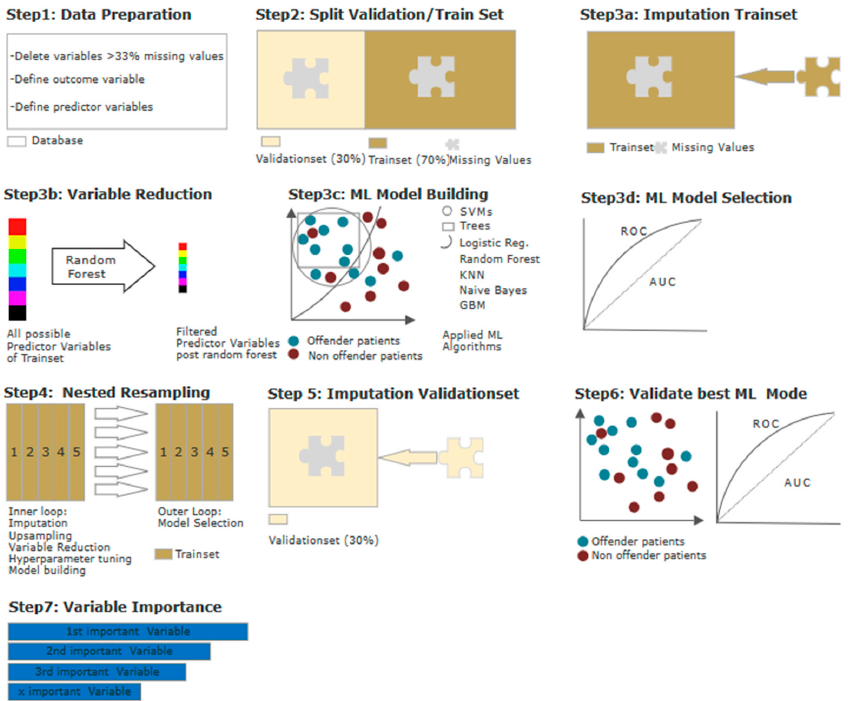
Figure 1. Machine learning model building and validation, step by step: Step 1—Data preparation: Multiple categorical variables were converted to binary code. Continuous and ordinal variables